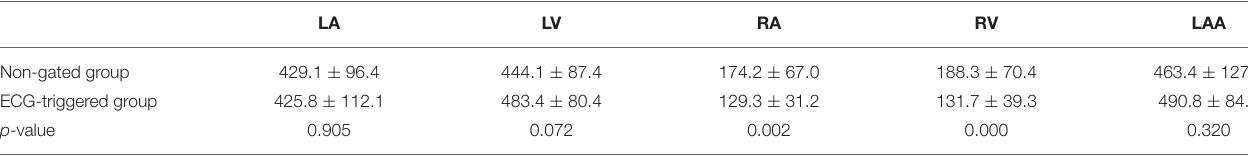
TABLE 4 | Quantitative analysis of each chamber and LAA (mean attenuation, Hu).